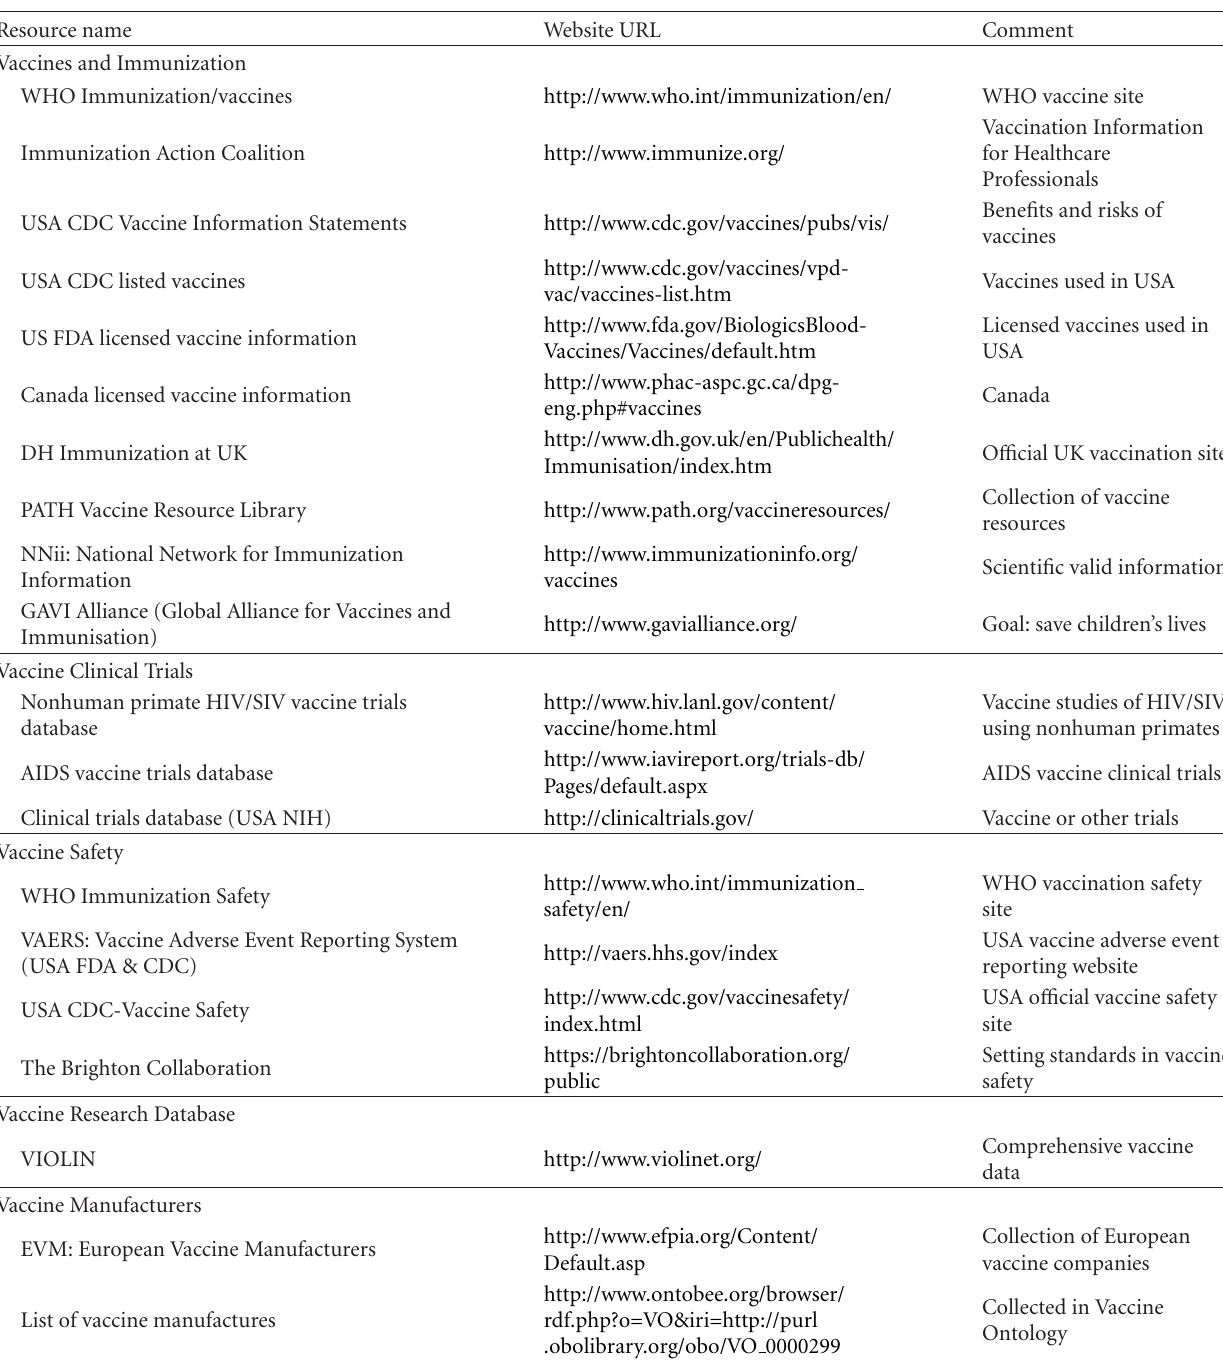
Table 3: Vaccine web